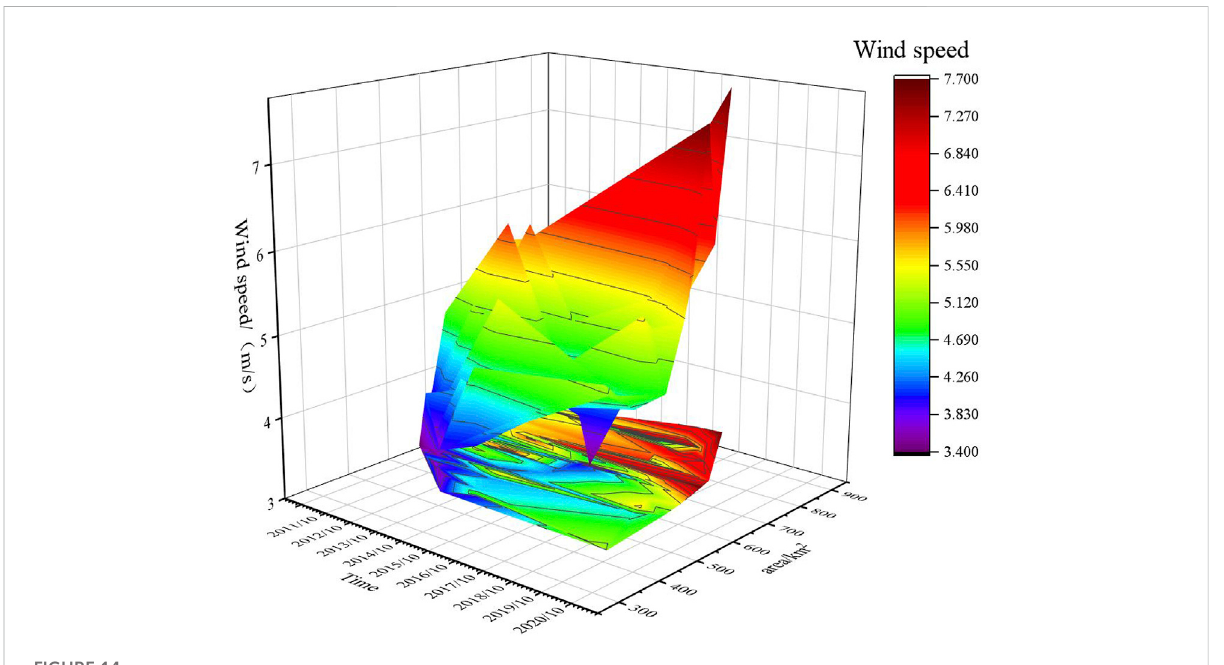
FIGURE 14 Relationship between time, wind speed and lake surface